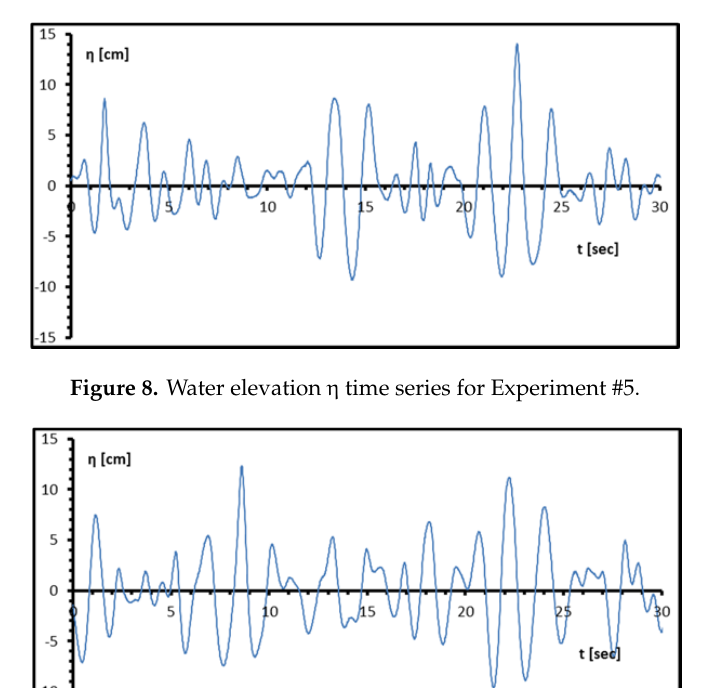
Figure 7. Water elevation η time series for Experiment #4.